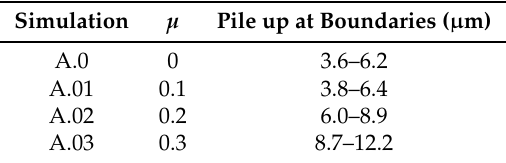
Table 7. Pile up effect estimation after all simulations with the same residual stress